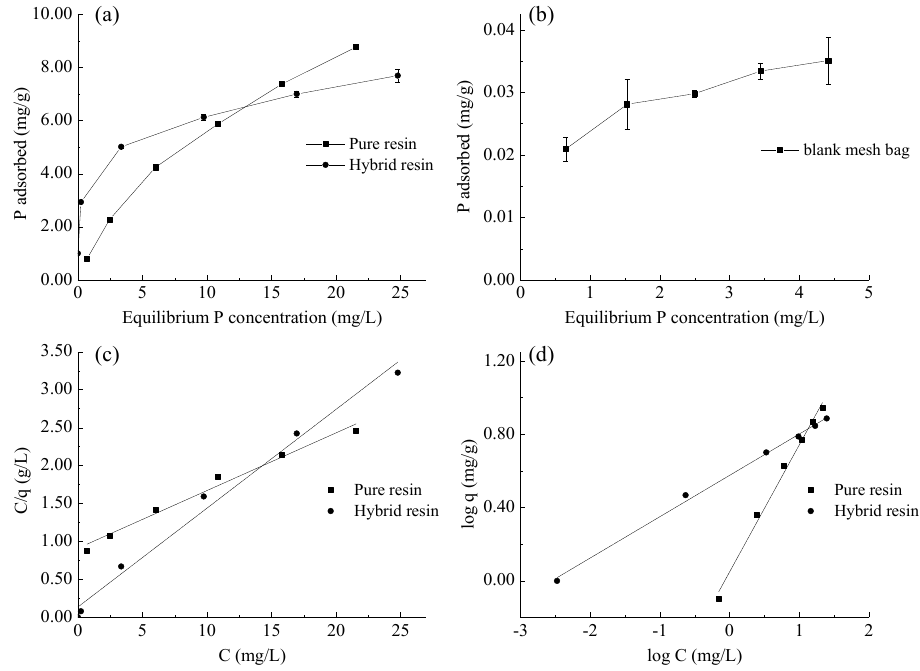
Figure 3. ( a ) Phosphate adsorption isotherm at pH 7.5 in the pure anion exchange resin and the hybrid resin; ( b ) phosphate adsorption isotherm at pH 7.5 in a blank mesh bag; ( c ) Langmuir model of the isotherm data in Figure 3a; ( d ) Freundlich model of the isotherm data in Figure 3b.